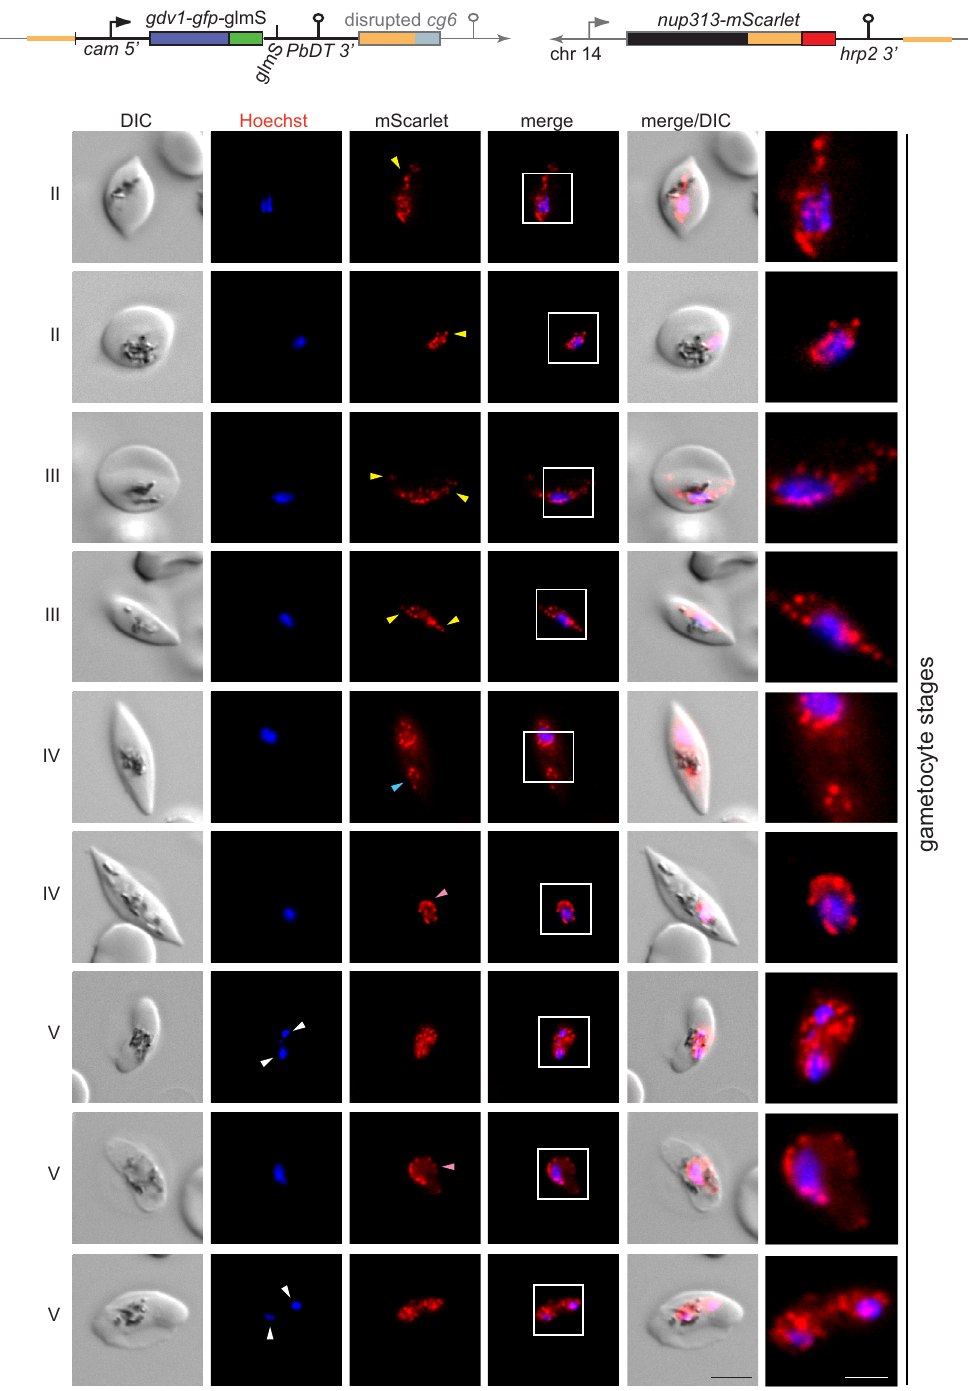
Fig. 5 Nuclei in stage II – V gametocytes undergo marked morphological transformations. Schematic maps of the disrupted cg6 locus carrying a single inducible GDV1-GFP-glmS expression cassette and the tagged nup313 locus in double-transgenic NF54/iGP2_NUP313-mSc line are shown on top. The 5 ′ and 3 ′ homology regions used for CRISPR/Cas9-based genome editing are shown in orange. Live-cell fl uorescence microscopy images showing the localisation of NUP313-mScarlet (red) in stage II to V gametocytes. Lateral extensions (yellow arrowheads) or rounded expansions (pink arrowheads) of the nucleus away from Hoechst-stained bulk chromatin and separate NUP313-mScarlet-delineated regions enclosing (white arrowheads) or devoid of Hoechst-stained bulk chromatin (blue arrowhead) are highlighted. II – V, stage II to V gametocytes. DIC, differential interference contrast. Nuclei were stained with Hoechst. Images are representative of four biologically independent experiments. Scale bar, 5 µ m. White frames refer to the magni fi ed view presented in the rightmost images (scale bar, 2 µ